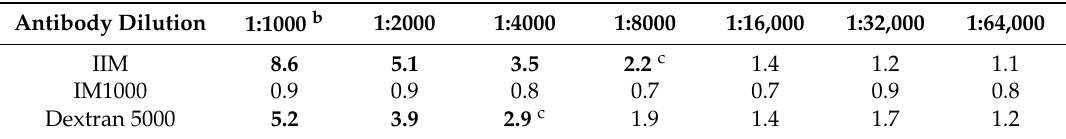
Table 2. ELISA results, A 450 ratios (sample/blank), for the reactivity of IIM and IM1000 (IIM carbohydrate) with 5E7H3 antibody a . Antibody Dilution